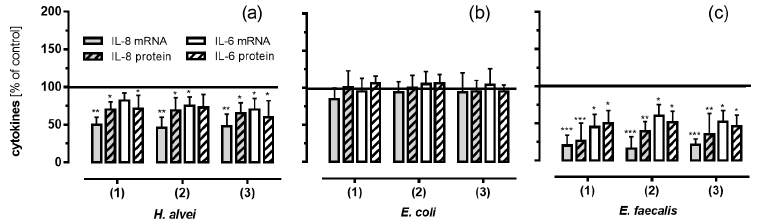
Figure 6. The effect of ACNs fermented by H. alvei ( a ); E. coli ( b ) and E. faecalis ( c ) on cytokine mRNA and protein secretion in HUVECs under LGI conditions and long-term incubation. After incubation of Caco-2 cells with fermented ACNs from the lag- (1), log- (2) and stat-phase (3), transwell inserts were removed, and the co-cultured HUVECs were further incubated for 20 h. After TNF- α stimulation, mRNA and protein expression were measured as described in the Materials and Methods section.